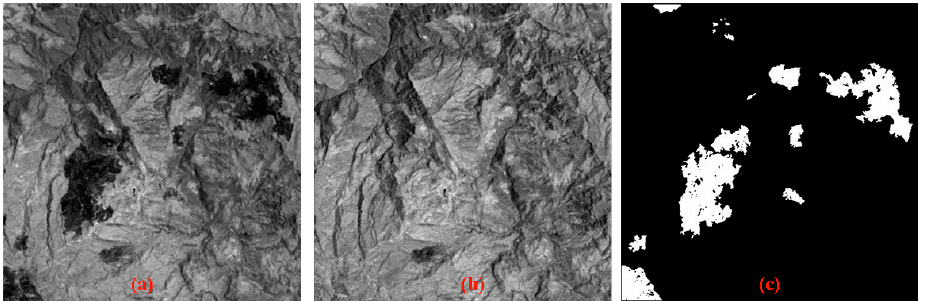
Figure 6. Fourth data set: Mexico data, band 4 of the Landsat TM image captured in ( a ) April 2000; ( b ) May 2002; and ( c ) reference map for the changed area.